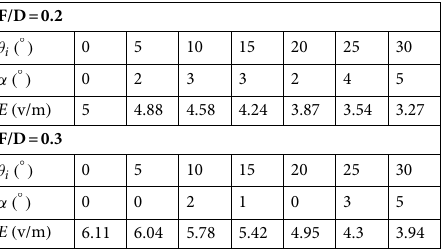
Table 2. The values of angle α as well as the amplitude of the electric field at the focused spots for different focused spot locations and different F/D values.